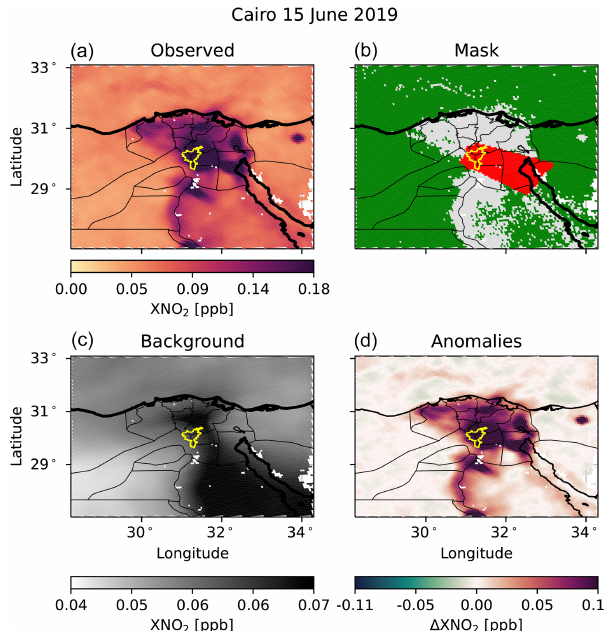
Figure 3. An example of the background and anomaly calcula- tion procedure for TROPOMI NO 2 observations over Cairo on 15 June 2019. Panel (a) shows the smoothed set of observations. Panel (b) shows the mask for the background calculation; green points are below the 75th percentile and used in the calculation, while grey points are omitted, and red points indicate observations in the enhancement. The selection of the enhancement region is done liberally, as the location of OCO-2/3 observations is often a more limiting factor. Panel (c) then shows the derived background, and panel (d) shows the calculated anomalies. The extent of the GHS polygon for Cairo is shown in yellow. Thick black lines mark coastlines, and thin black lines indicate geopolitical boundaries.